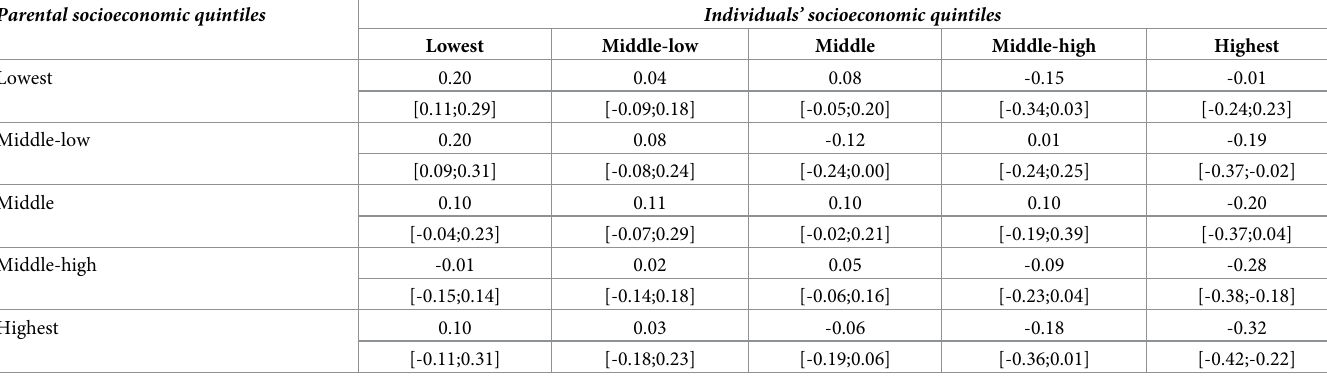
Table 2. Mean AL levels by parental and individuals’ socioeconomic position. Parental socioeconomic